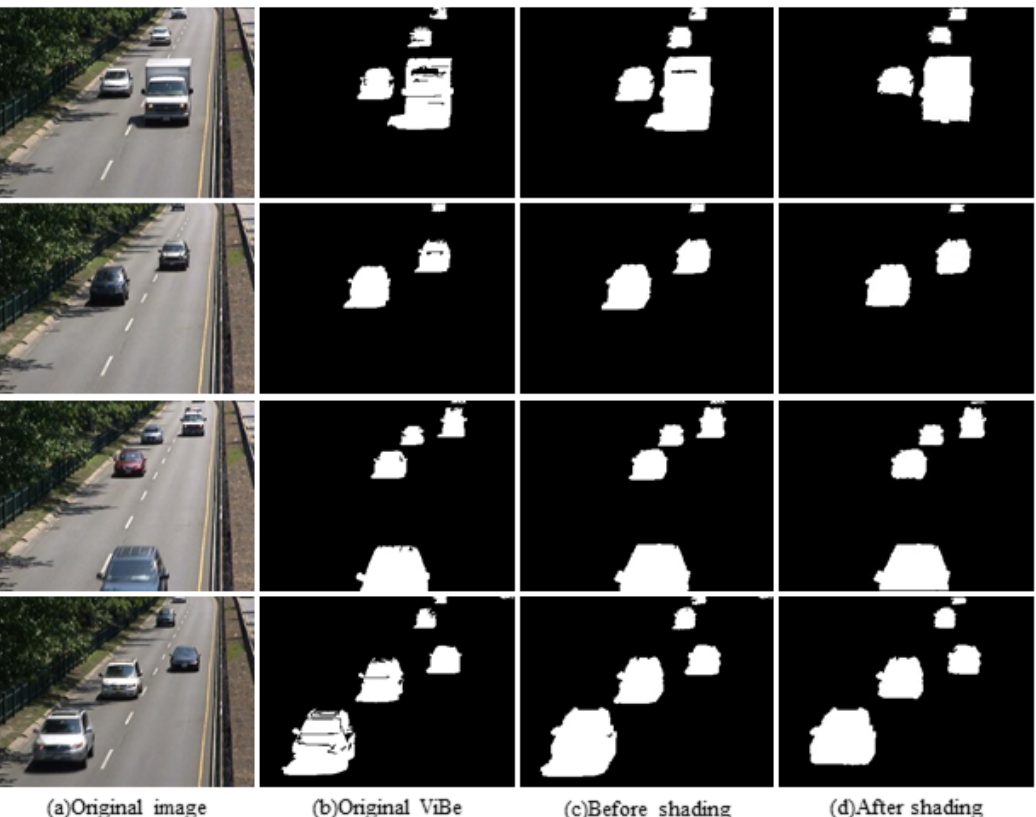
Figure 9. Partial comparison chart of CDnet dataset.